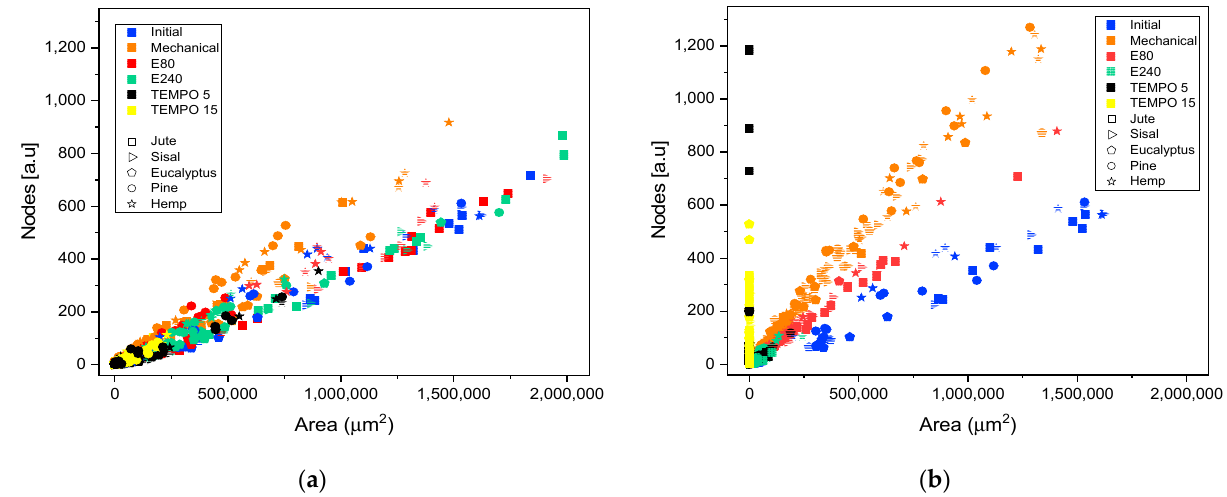
Figure 7. Evolution of the number of nodes quantified in the elements identified in optical microscopy images and transmission electron microscopy with their projected area, when different pretreatments are applied to produce cellulose micro and nanofibers from different sources: ( a ) after pretreatment without homogenization; ( b ) after pretreatment and HPH at PS5.